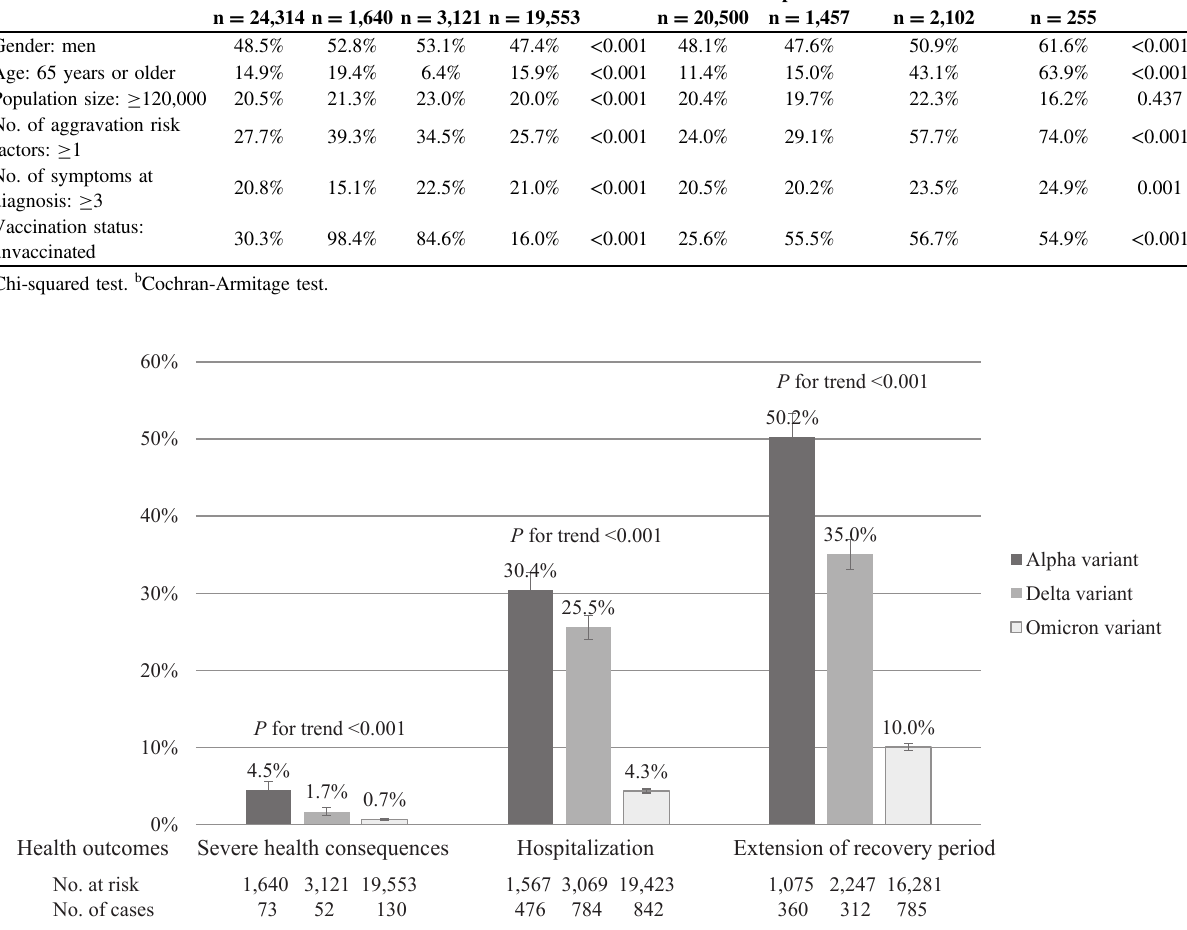
Fig. 1 Cumulative incidence of individuals with a health outcome by SARS-CoV-2 variant type. A trend test was performed to detect a decrease in the cumulative incidence of a health outcome with the emergence of new variants using the Cochran-Armitage